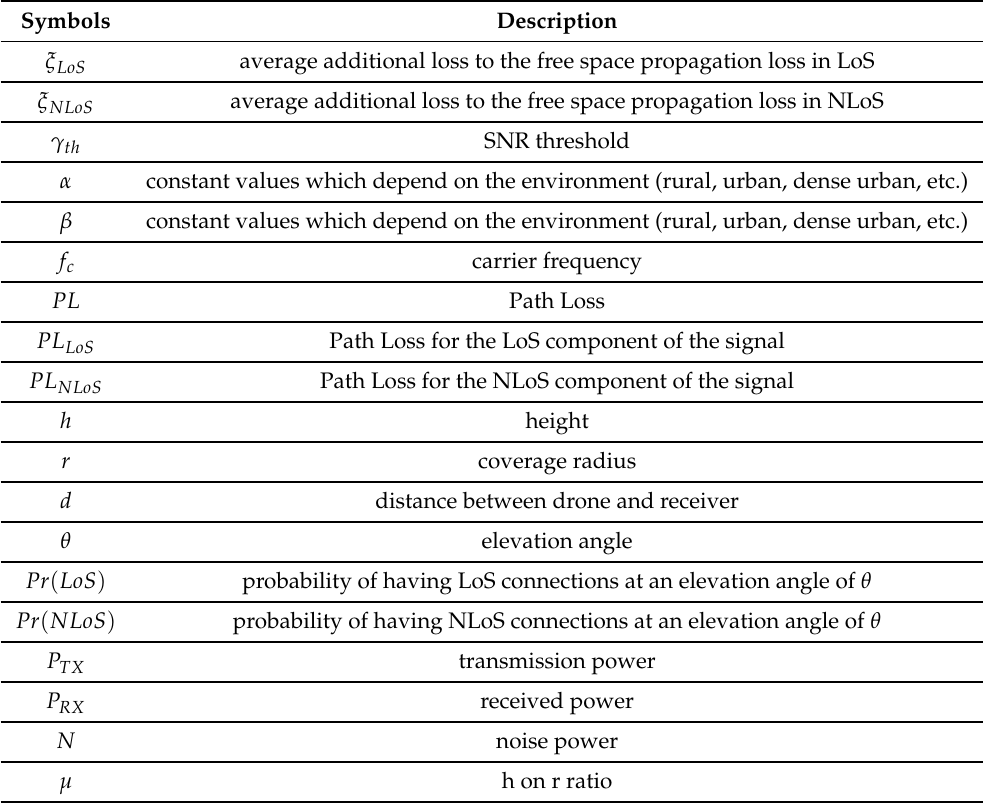
Table 3. Footprint coverage model: used